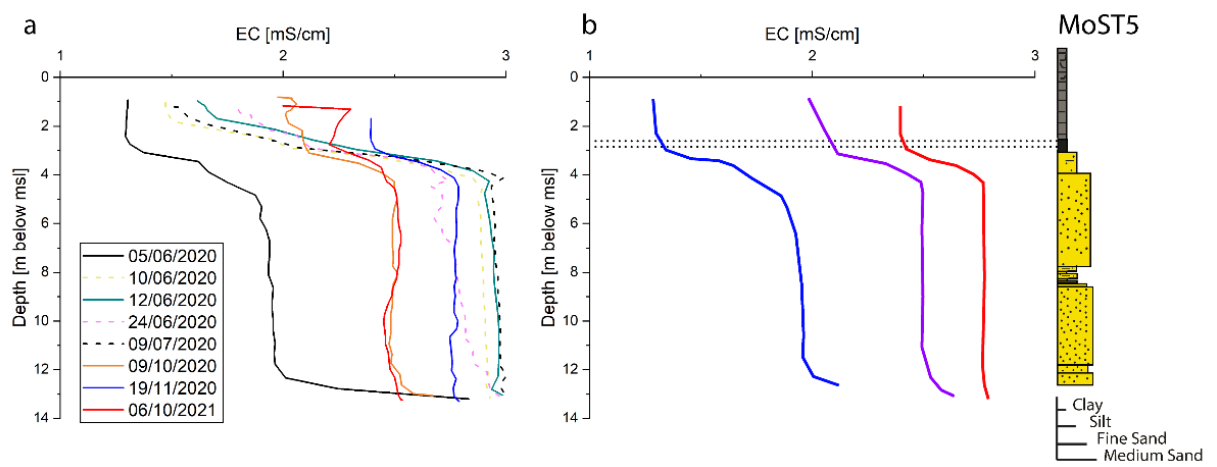
Figure 9. EC profiles collected in MoST5 well. Panel ( a ) shows the configurations assumed by the EC curve during the observed period. The model of panel ( b ) summarizes the configurations and compares them with the stratigraphic section, outlining the sedimentary constraint (dotted area) existing in the subsoil surrounding the monitoring point.